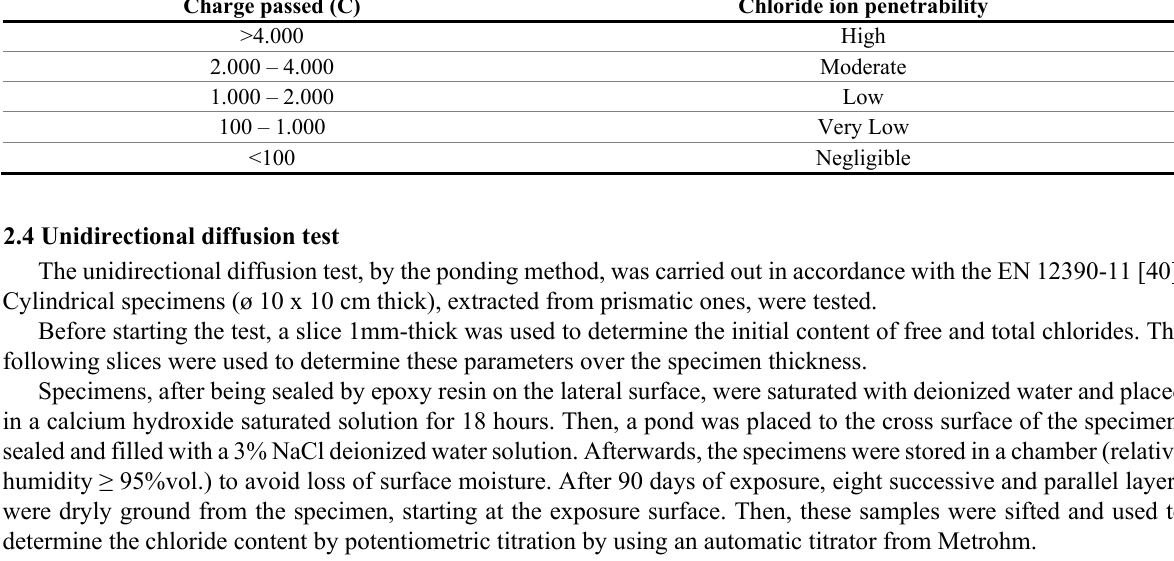
Table 6. Chloride Ion Penetrability Based on Charge Passed [39]. Charge passed